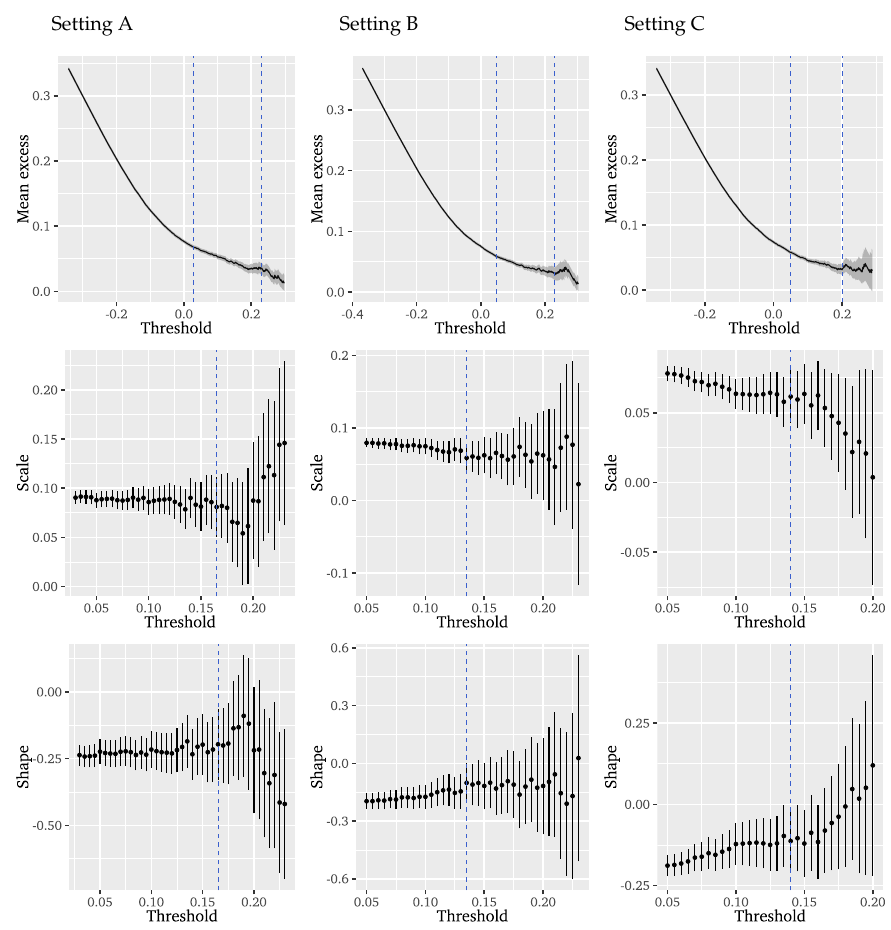
Figure A5. Mean residual life plot and GPD parameter stability plots for the ARFIMA residuals of the simulated settings A, B and